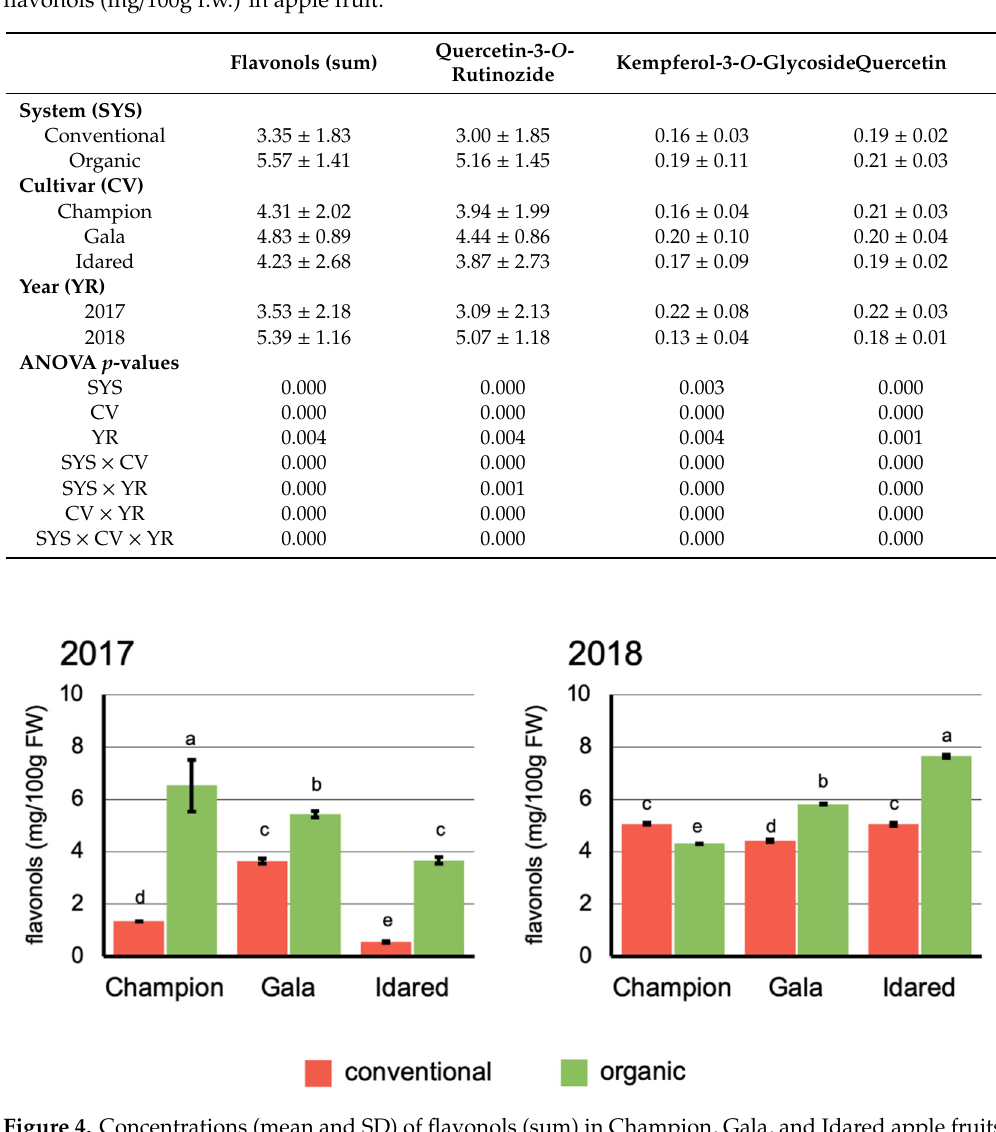
Figure 4. Concentrations (mean and SD) of flavonols (sum) in Champion, Gala, and Idared apple fruits collected from organic and conventional orchards in 2017 and 2018 growing seasons. Within each season and group of compounds, bars marked with the same letters are not significantly different at p < 0.05.